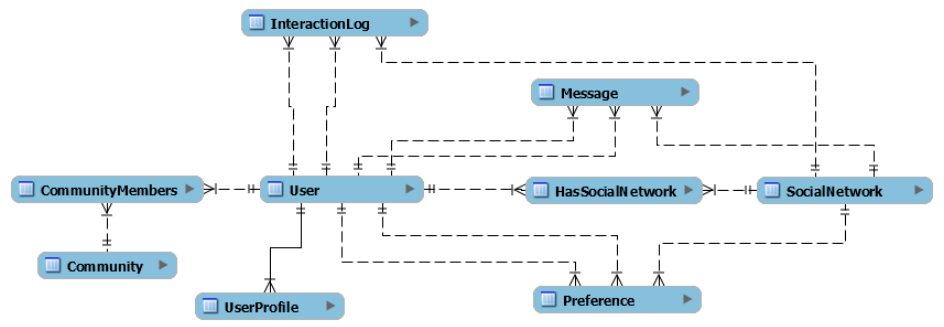
Figure 5. Data model of the SMT